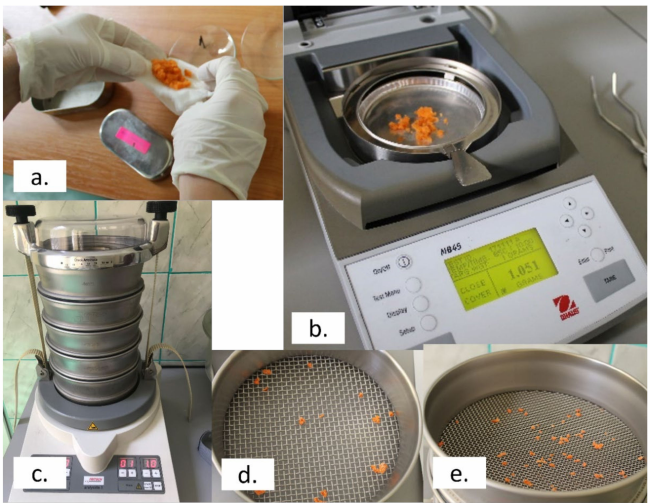
Figure 1. Workflow with main operational steps: ( a ) food bolus collected just before swallowing; ( b ) determining the mass and drying of the food bolus (device used: MB45 Moisture Analyzer; OHAUS); ( c – e ) assesssing food comminution by multiple sieve method (device used: Vibratory Sieve Shaker ANALYSETTE 3 PRO;